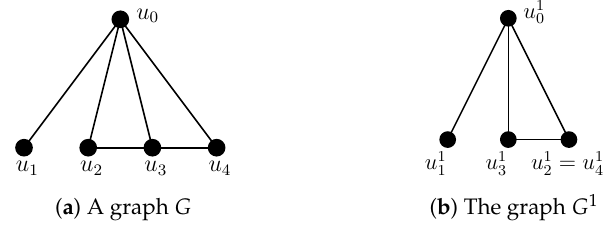
Figure 2. A graph G and its twin graph G 1